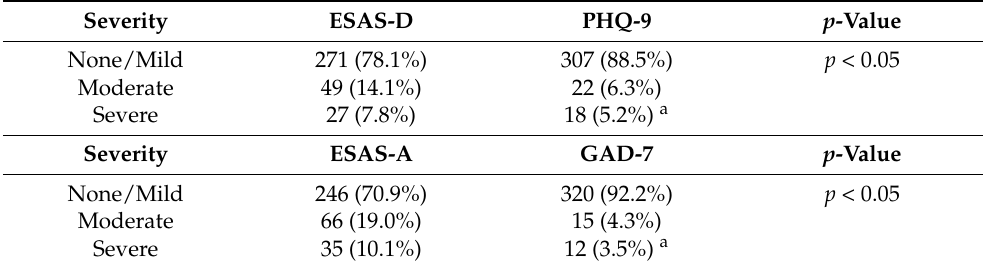
Table 1. Distress prevalence at diagnosis across PHQ-9, GAD-7, ESAS-D, and ESAS-A from HNC patients seen at PM between 2010 to March 2013 (n = 347).